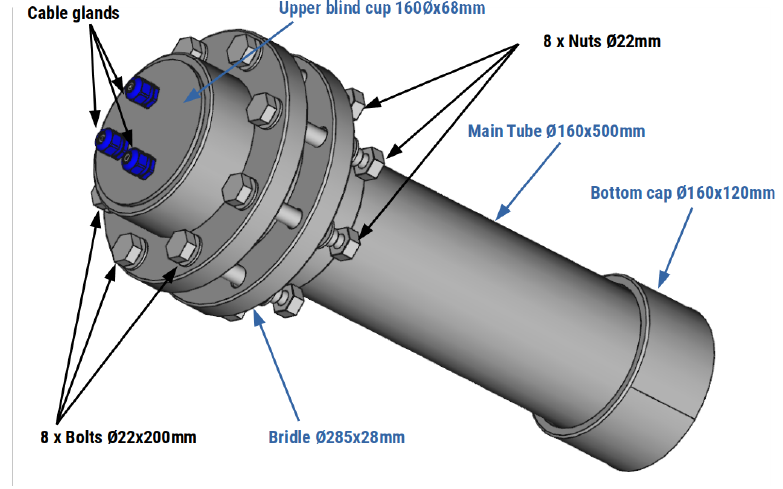
Figure 3. Isometric view of the MASE’s housing. Table 1. Materials for the construction of the cover (where